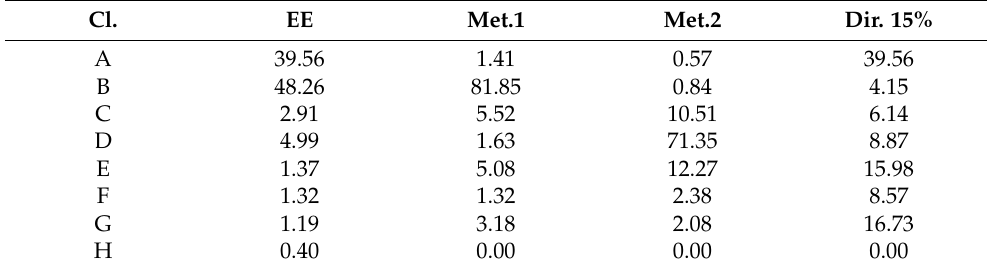
Table A2. EPC certificates % per energy class, dwellings D2 (A = 120 m 2 –220 m 2 ). Cl.